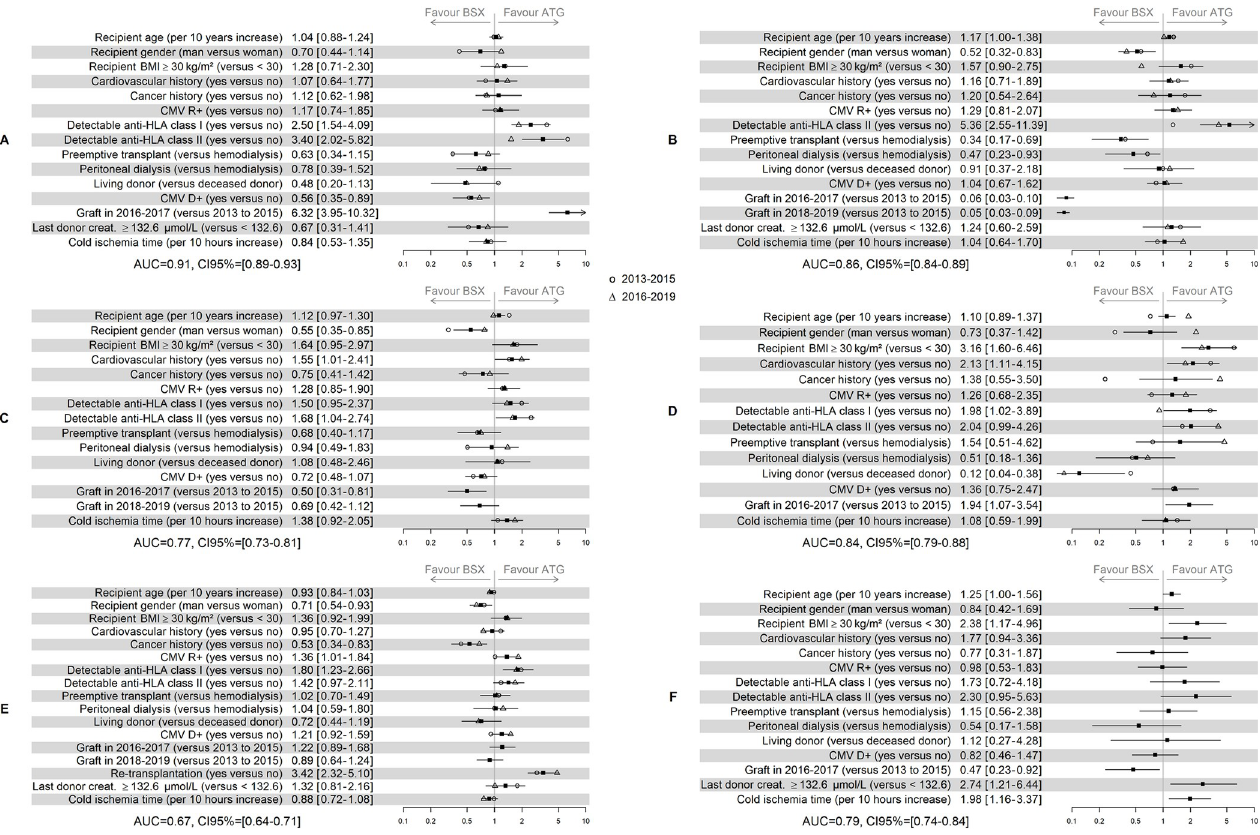
Fig 2. Results of the six logistic regressions aiming to illustrate the factors associated with the choice of induction therapy. n = 484 for center A (only first transplant and transplants performed from 2013 to 2017), n = 604 for B (only first transplant and non-detectable anti-HLA Class I), n = 577 for C (only first transplant and last donor creatinemia < 132.6 μ mol/L), n = 276 for D (only first transplant and last donor creatinemia < 132.6 μ mol/L), n = 1045 for E, and n = 271 for F (only first